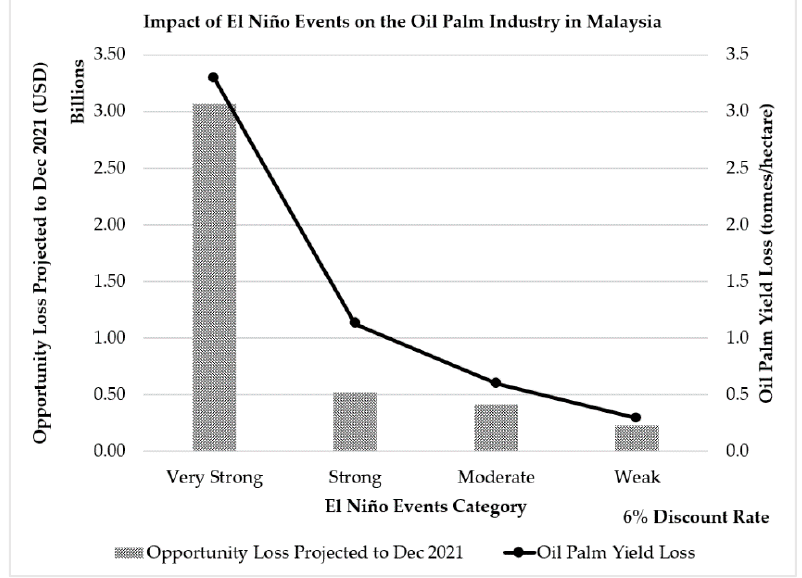
Figure 4. Oil palm yield loss and opportunity loss due to El Niño according to category. This study then accumulates the opportunity losses at a hypothetical 6% discount rate to show the collective impact of every El Niño event from January 1986 to June 2021 (except for 2018/19 weak El Niño) on the oil palm industry in Malaysia (Figure 5). The total combined loss is estimated to be 9.55 billion USD by the end of 2021, which is approximately 2.84% of Malaysia’s GDP in 2020 [11]. Using SPSS, the cumulative opportunity losses model was modelled with a cubic model with an adjusted R-squared of 0.985, standard error of estimate of 0.331 billion USD and significant at p -value less than 0.0001 (Figure